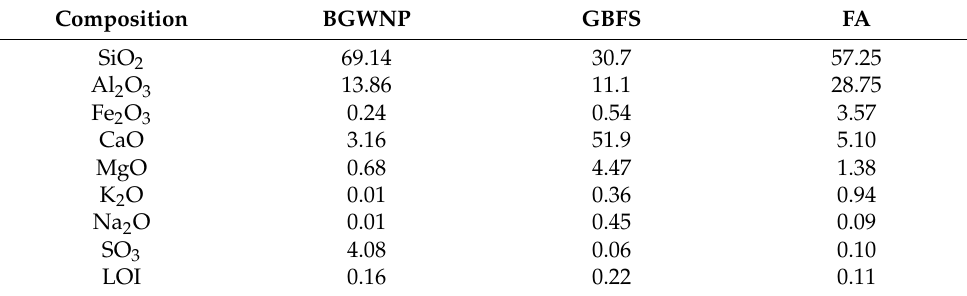
Table 1. Chemical compositions of BGWNP, GBFS, and FA, mass %.